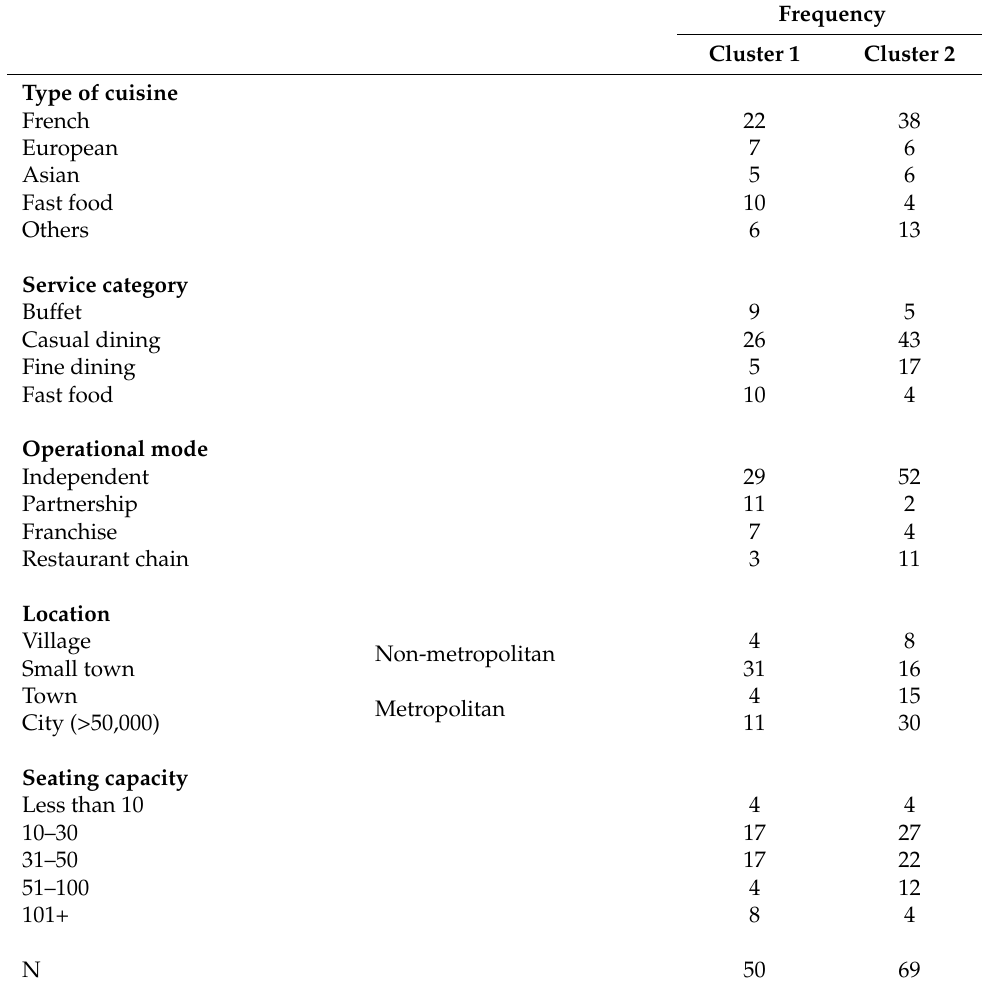
Table 3. Profile of restaurants participating in the